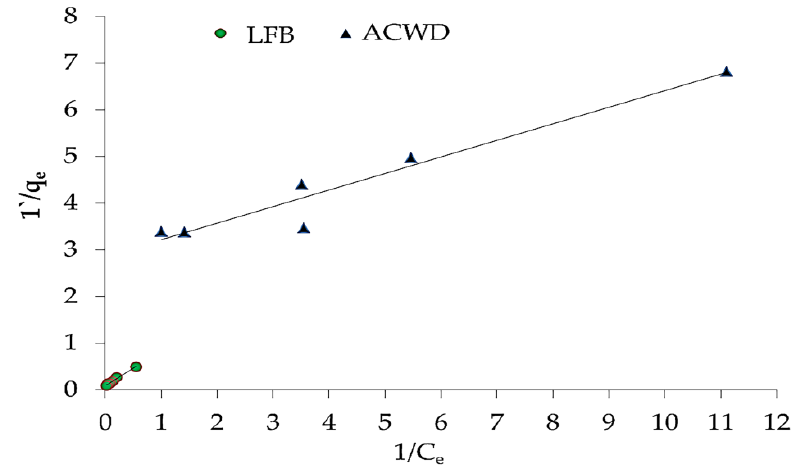
Figure 8. Freundlich isotherm plot for the sorption of ammonia using whole biomass (ACDW) and lipid ‐ free biomass (LFB) of Arthrospira platensis.